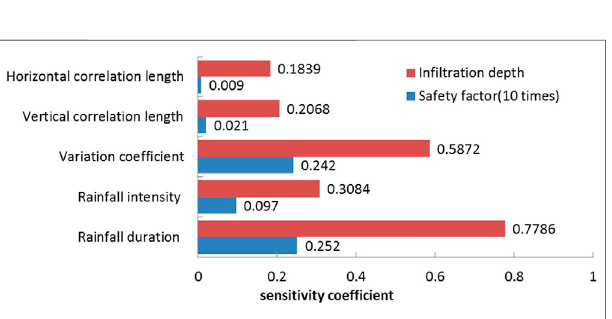
Frontiers in Earth Science |